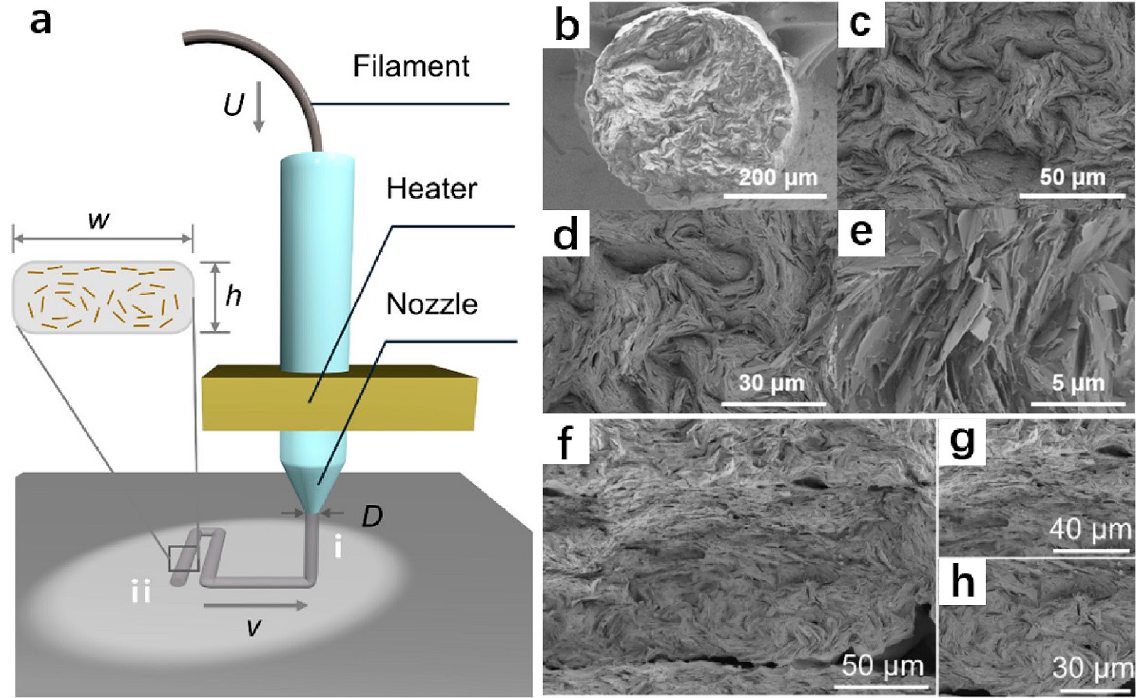
Figure 10. ( a ) Schematic illustration of the FFF printing process of graphene/TPU composites, including extrusion and deposition processes; SEM image of ( b ) a cross section of a 40% graphene/TPU filament; ( c – e ) enlarged view of the cross section of the filament; ( f ) asymmetric structure of the printed filament; ( g ) top-aligned graphene sheets; ( h ) graphene sheet with a helical bottom (reproduced with permission from Reference [68] , Copyright 2021 American Chemical Socie- ty).